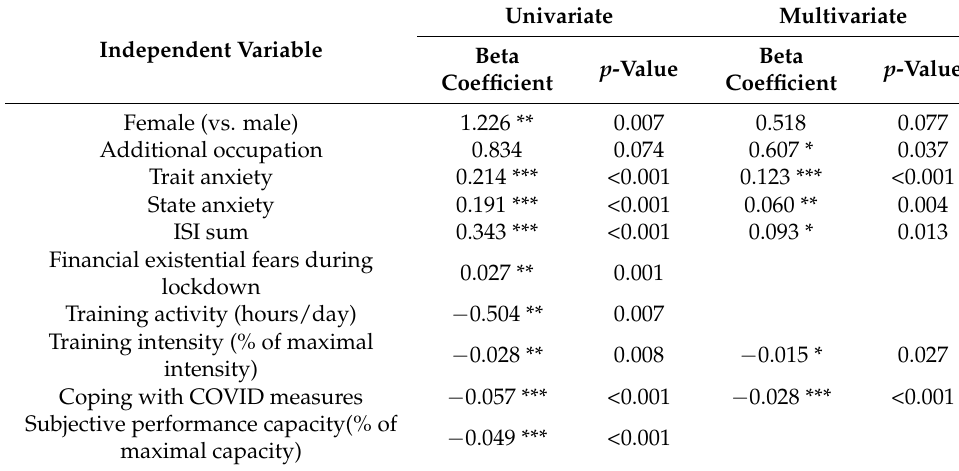
Table 4. Multivariate regression of PHQ-9 questionnaire